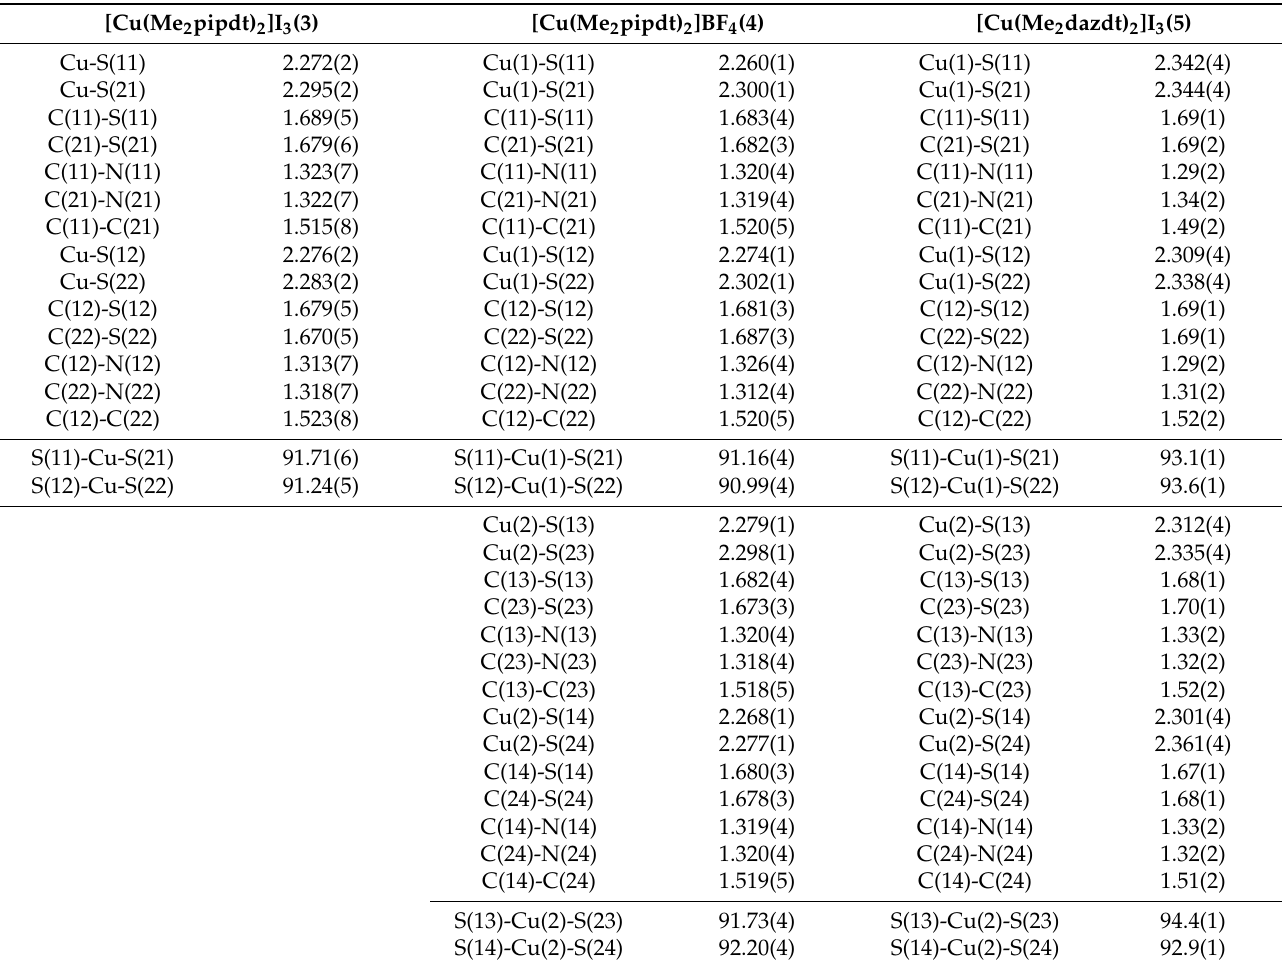
Table 3. Selection of bond distances (Å) and angles ( ◦ ) for compounds [Cu(Me 2 pipdt) 2 ]I 3 ( 3 ), [Cu(Me 2 pipdt) 2 ]BF 4 ( 4 ) and [Cu(Me 2 dazdt) 2 ]I 3 ( 5